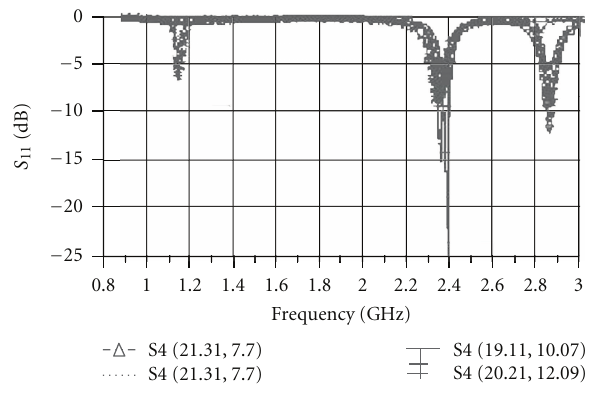
Figure 5: Comparison between di ff erent feed positions for third iteration